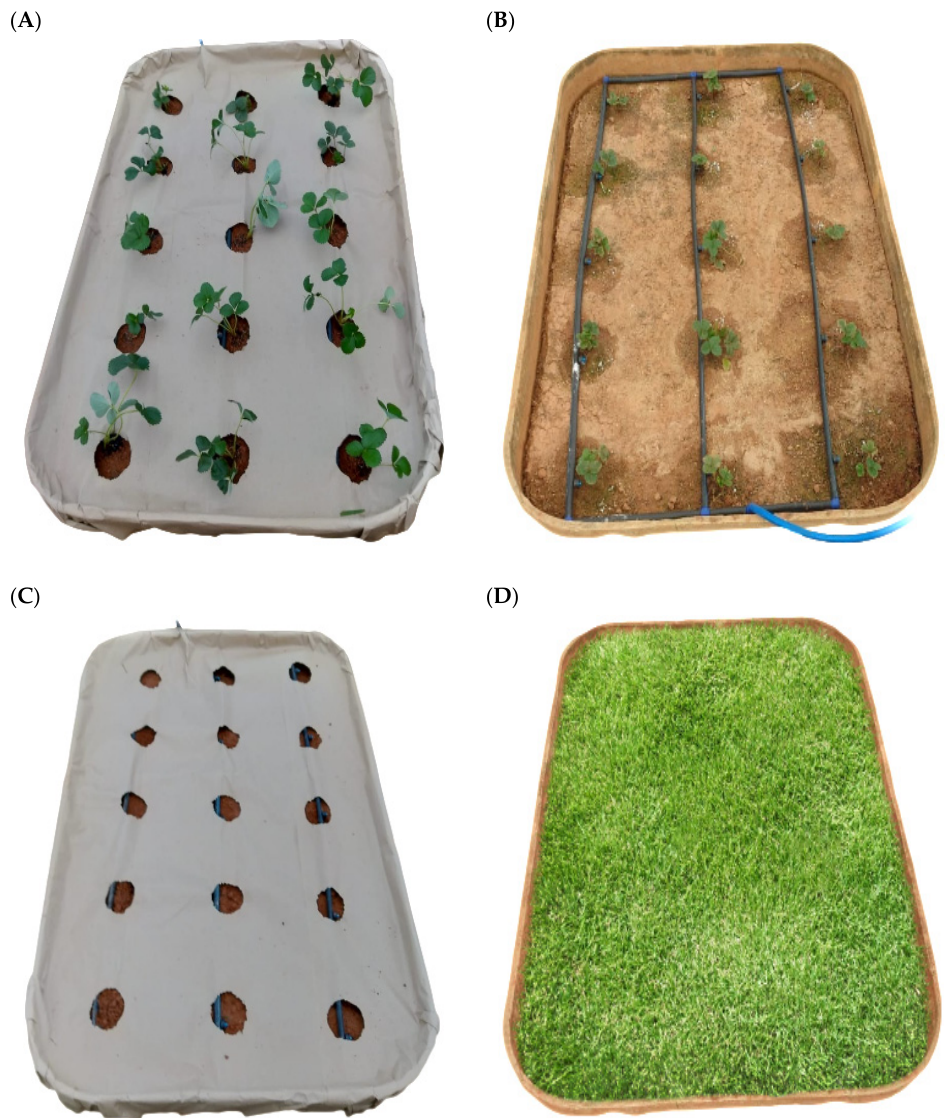
Figure 1. ( A ) Strawberry with recycled paper mulch (SWiP), ( B ) strawberry without recycled paper mulch (SWoP), ( C ) lysimeter only with recycled paper mulch (OPM), and ( D ) lysimeter cultivated with Bahiagrass (CBG).